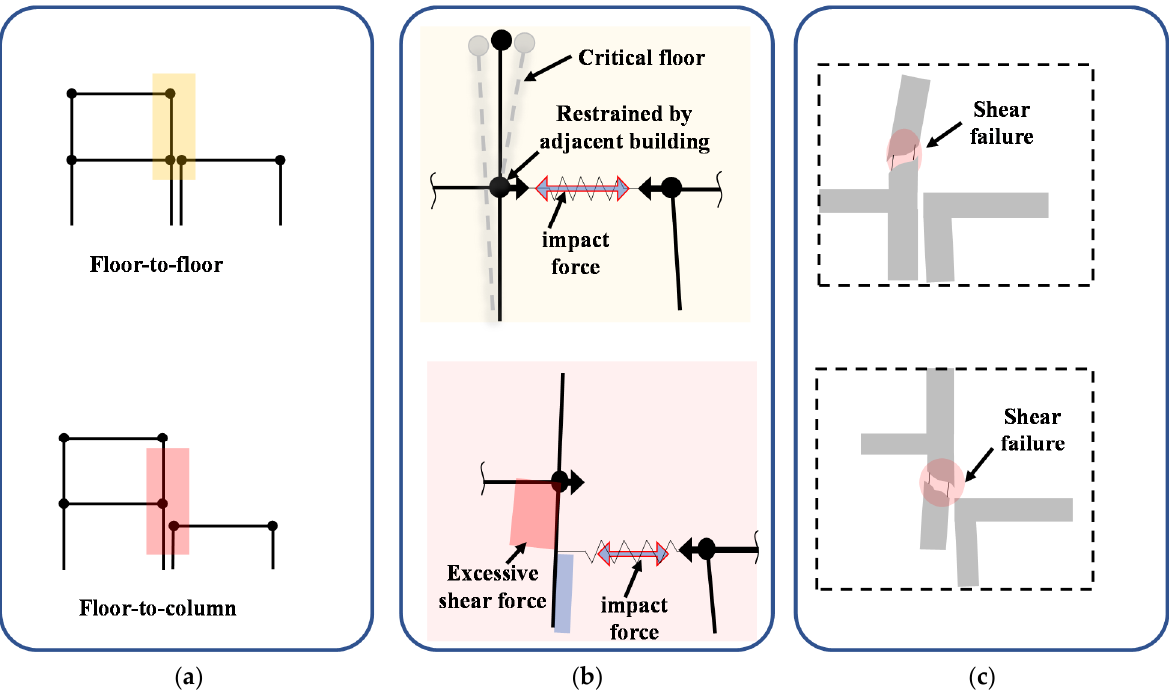
Figure 16. Illustration of the type of shear failure associated with each type of pounding configuration: ( a ) pounding configuration, ( b ) load path and ( c ) observed shear failure.